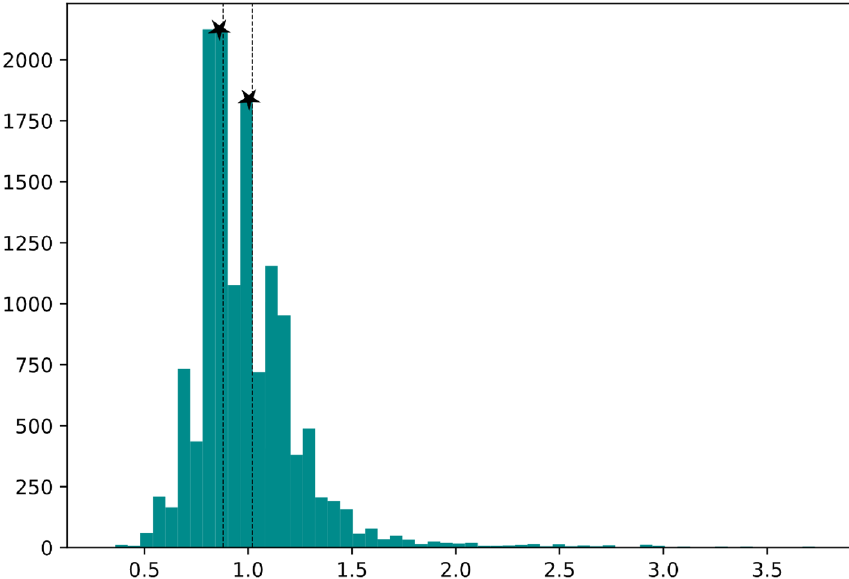
Figure 2. The selected cutting points to discretize the creatinine. The two cutting points at 0.88 and 1.02 are indicated using dashed